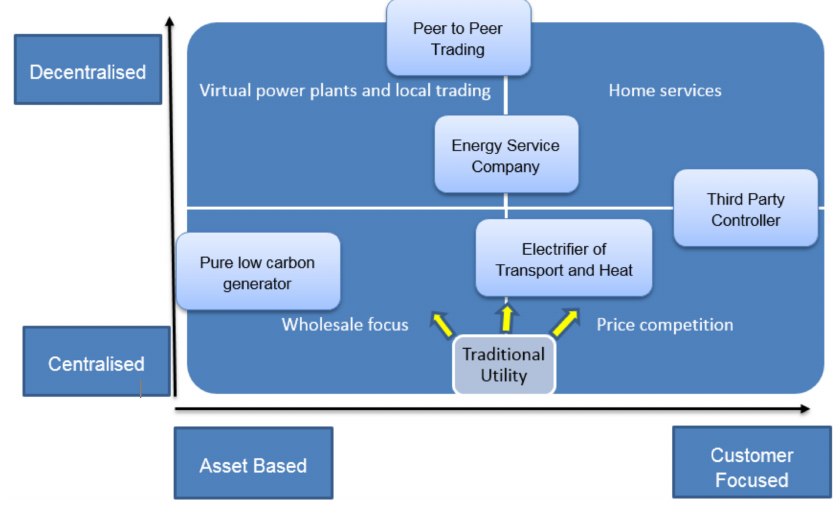
Figure 1. Future Business